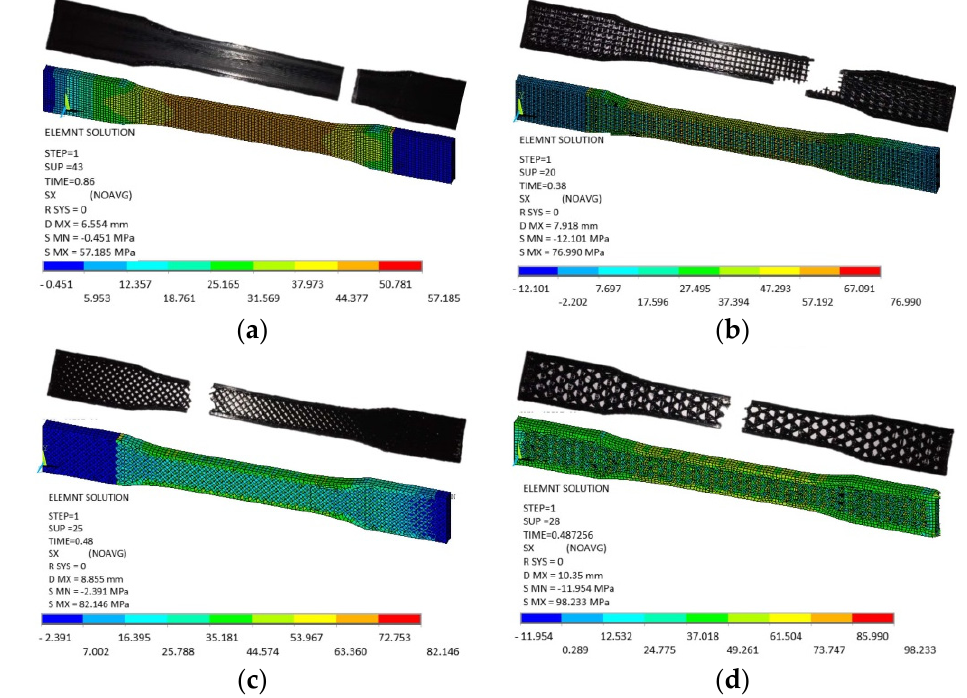
Figure 14. Engineering stress–strain curves for hexagonal tested specimen based on experimental and finite element analysis.